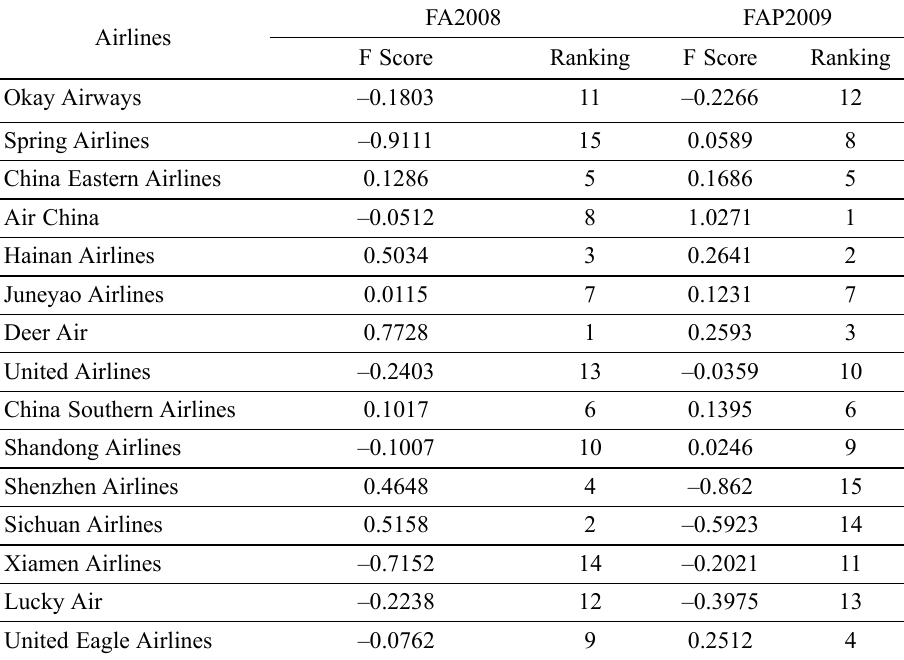
Table 14. Scores and the rankings of Chinese airlines based on FA